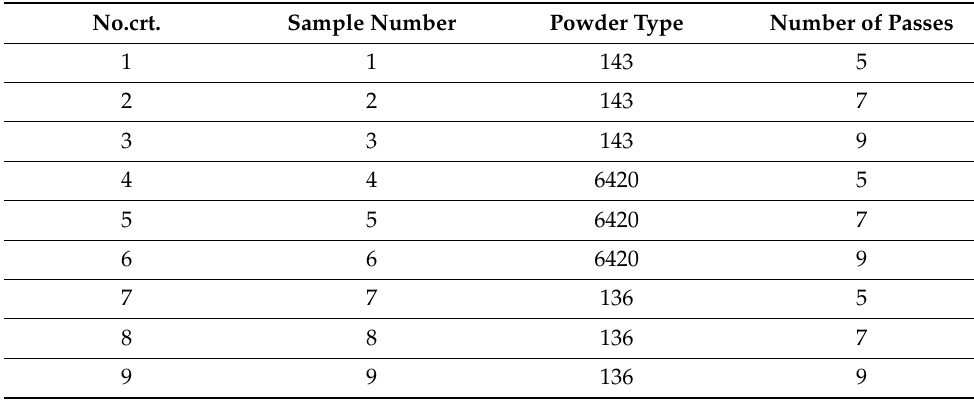
Table 2. Experimental plan used to cover the samples with ceramic layer.